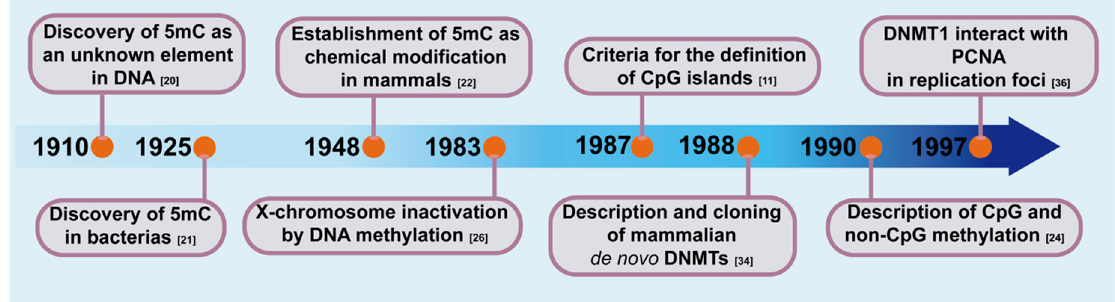
Figure 1. Timeline of key findings that led to the discovery and role definition DNA methyltransferases (DNMTs) in mammalian genomes and gene